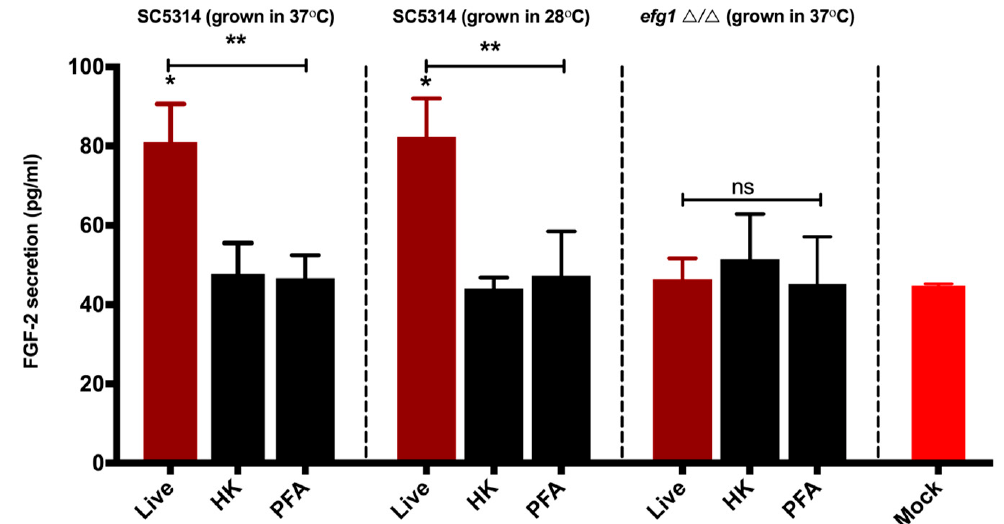
Figure 2. A factor(s) from viable C. albicans hyphae regulates the host FGF-2 response. C. albicans SC5314 (WT) strain was grown in Endothelial Cell Basal Medium (EBM) at 37 °C until germ tubes were visible (~3 hours). Controls were SC5314 grown at 28 °C and the efg1 △ / △ mutant at 37 °C for the same time period (during which no germ tubes were detected). Each group was split into three subgroups: no treatment (live) or treatment with heat (HK) or paraformaldehyde (PFA). HUVECs were challenged with live, HK-, or PFA-treated C. albicans and were maintained at 37 °C for 24 hours. FGF-2 levels in the culture supernatants were measured by ELISA. Both one-way ANOVA ( p = 0.009) and Dunnett’s multiple comparison test ( p < 0.05) showed statistically significant differences between the Mock and SC5314 live groups (as indicated by *). There was also a statistically significant difference between the live and nonviable groups (HK and PFA) in SC5314 groups (as indicated by ** for p < 0.05).